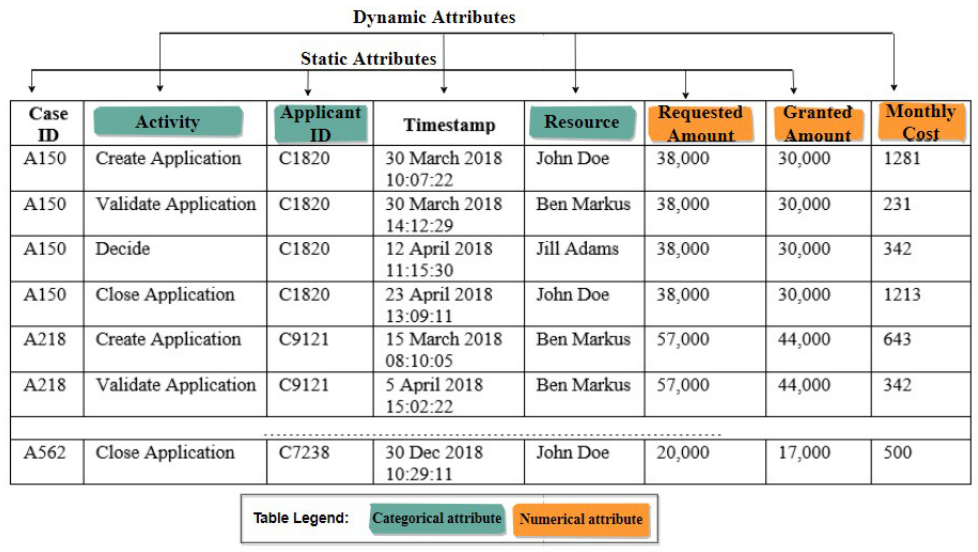
Table 1. Example loan application event